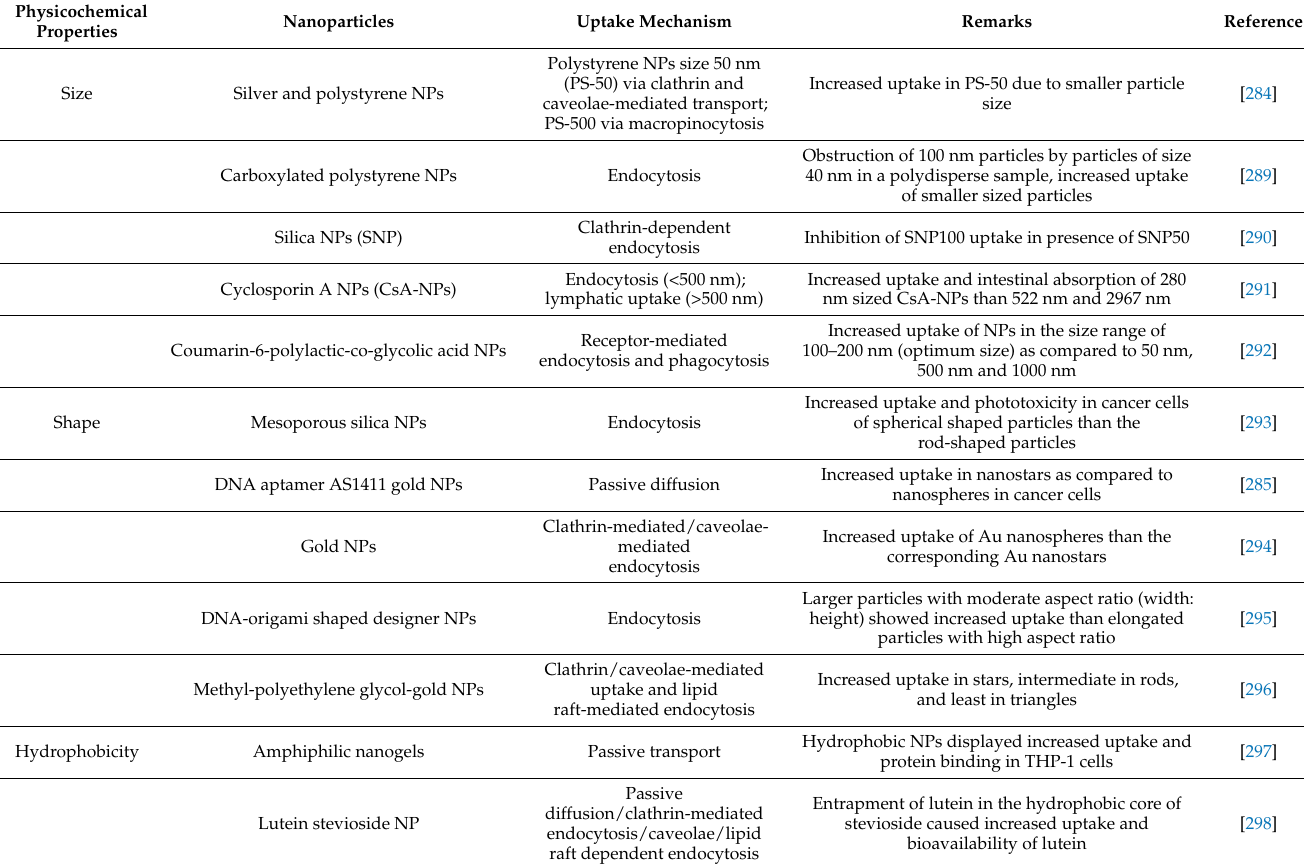
Table 4. NP physicochemical parameters and their impact on cellular